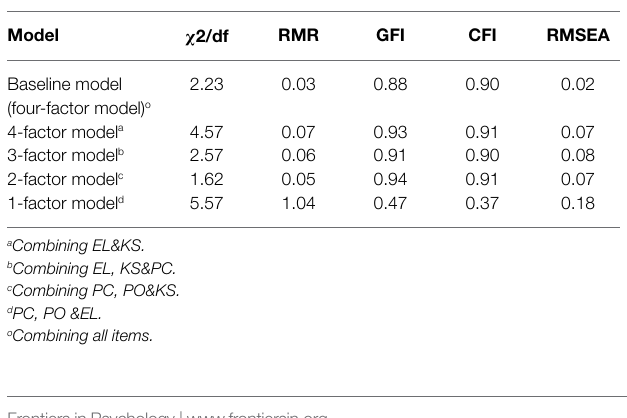
TABLE 2 | Results of the confirmatory factor analysis ( N =